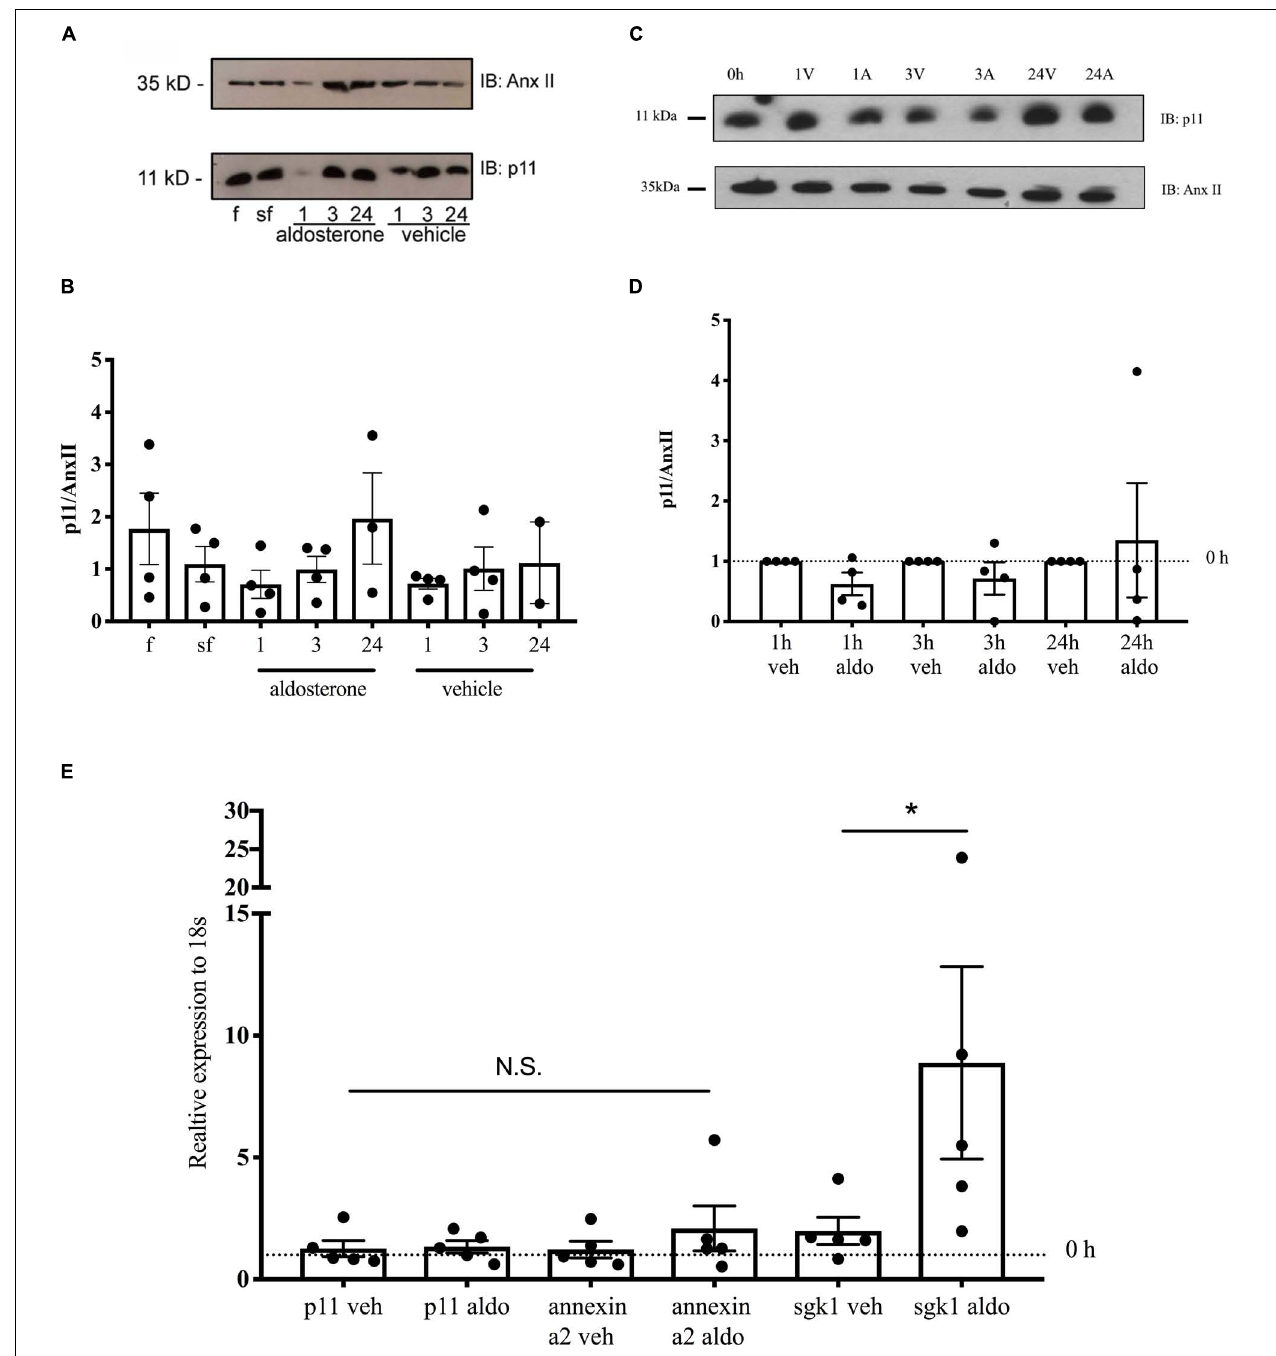
FIGURE 4 | Effect of aldosterone on the endogenous expression of p11. M1 CCD or mCCD cl1 cells were grown to 80% confluence in full medium (F) then 24 h in dexamethasone and serum-free (SF) medium before treatment with 10 nM aldosterone or ethanol (veh) for 1, 3, or 24 h. Cells were then lysed and immunoblotted (IB) for p11 subunit (Mr ∼ 11 kDa) and annexin II (Anx II or annexin a2) subunit (38 kDa), or used for qRT-PCR. (A,C) Representative western blot showing the presence of endogenous p11 and annexin II proteins in M1-CCD cells and the effects of aldosterone versus vehicle treatment. (B,D) Quantification of p11 protein level normalized to annexin II in M1 CCD or mCCD cl1 cells in culture conditions described above. (E) p11 , Annexin II, and Sgk1 expression is shown relative to expression of 18S following 1 h of 10 nM aldosterone treatment. The threshold value was automatically set by the CFX Manager software and the Ct value was calculated from the average of three technical replicates. Data are expressed as mean ± SEM ( n = 3–4 independent experiments) by one-way ANOVA followed by Bonferroni’s post-test where ∗ indicates a significant difference to control at a level of p < 0.05.